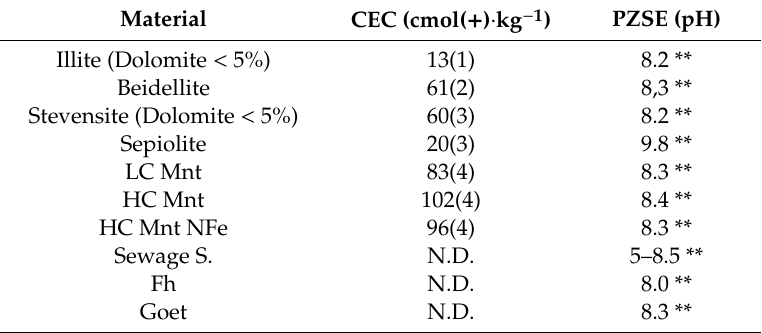
Figure 5. Experimental acid–base titration of sepiolite and smectitic materials for the point zero salt effect (PZSE) method obtained at various ionic strengths at 25 °C. Table 2. Physicochemical characteristics of sorbent materials used in this